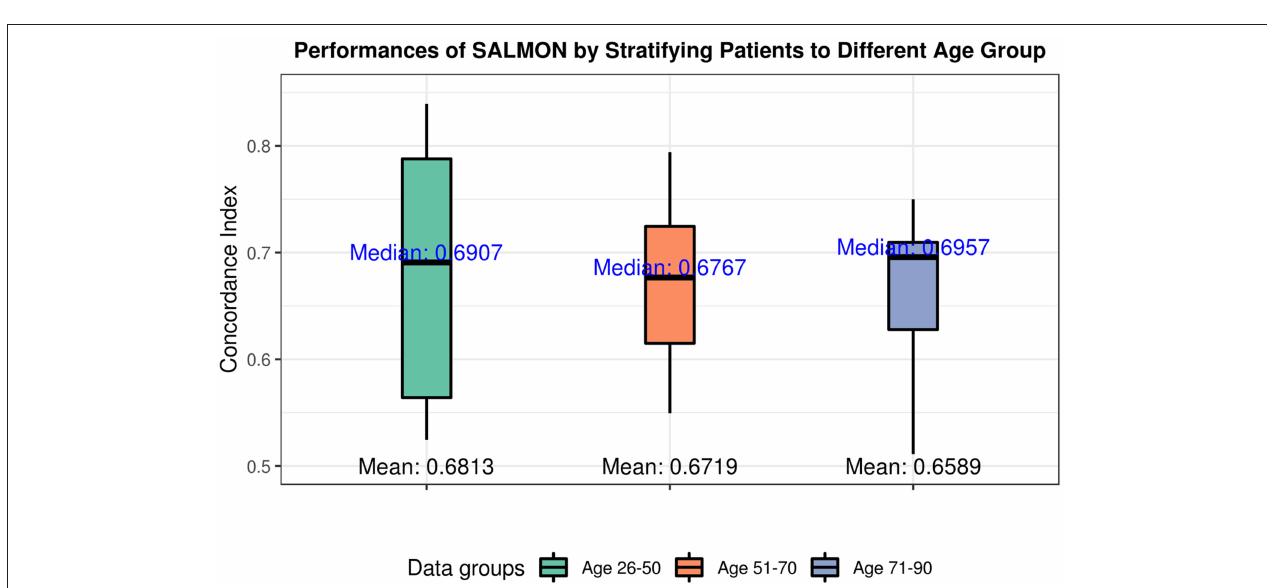
FIGURE 4 | Performances of SALMON algorithm stratified by three age groups: 26–50 group; 51–70 group; 71–90 group with integrating all omics data (integration of mRNA, miRNA, CNB, TMB, diagnosis age, ER status, PR status).